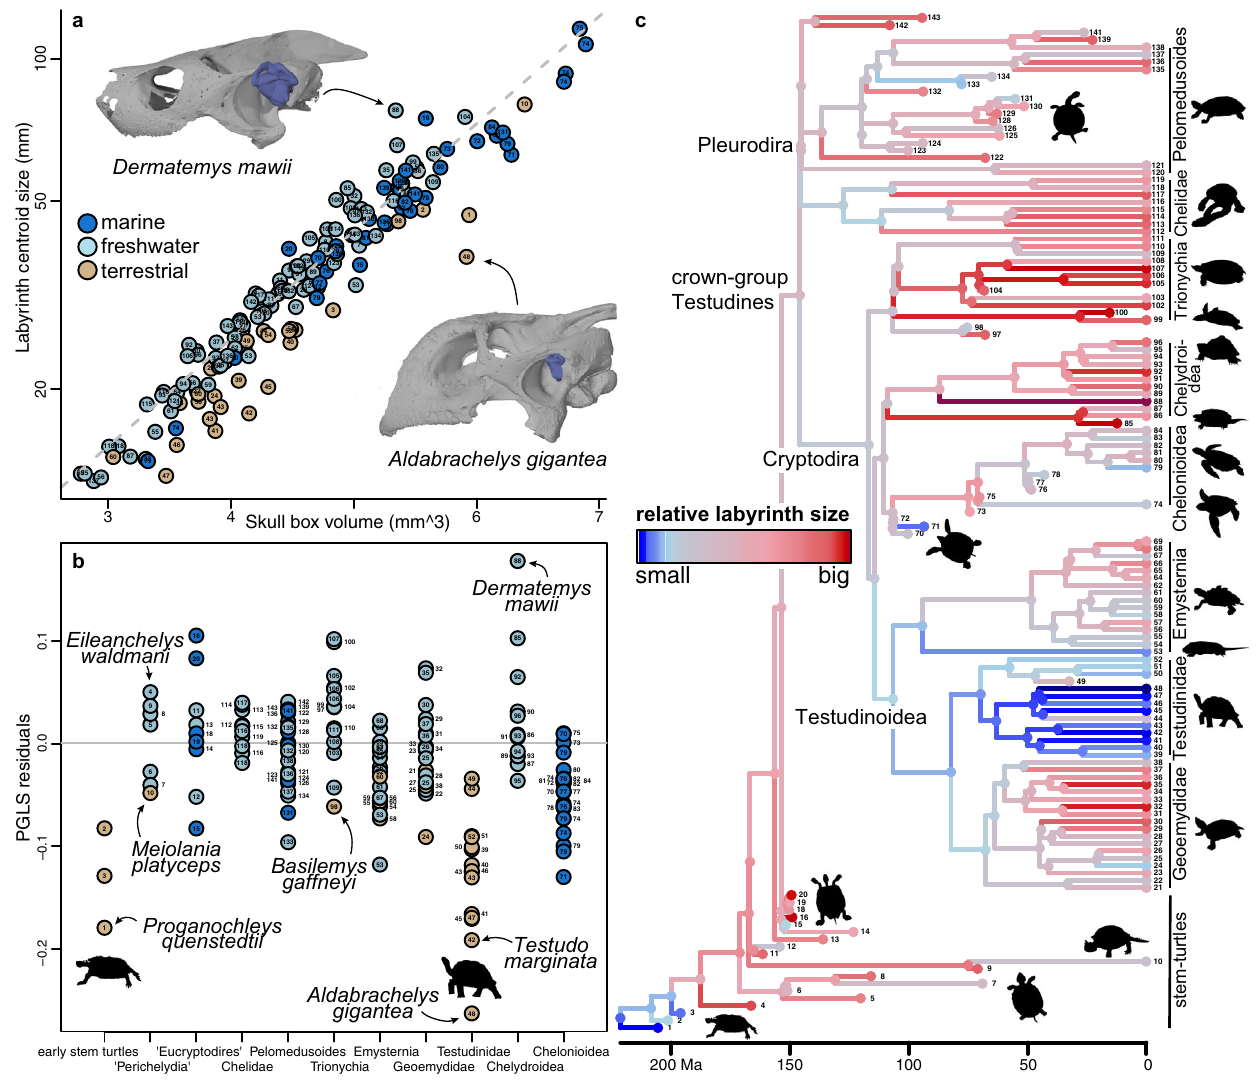
Fig. 3 | Relative labyrinth size in turtles. a PGLS regression of labyrinth size on skull box volume. Note that duplicate specimens for several species have been projected into graph but are not part of formal regression. Images show labyrinth models superimposed in original scale to skull models, with skull sizes of both specimens scaled to same length. b Residual plot of a , with specimens ordered according to major clades. c evolution of relative labyrinth size (scaled between 0